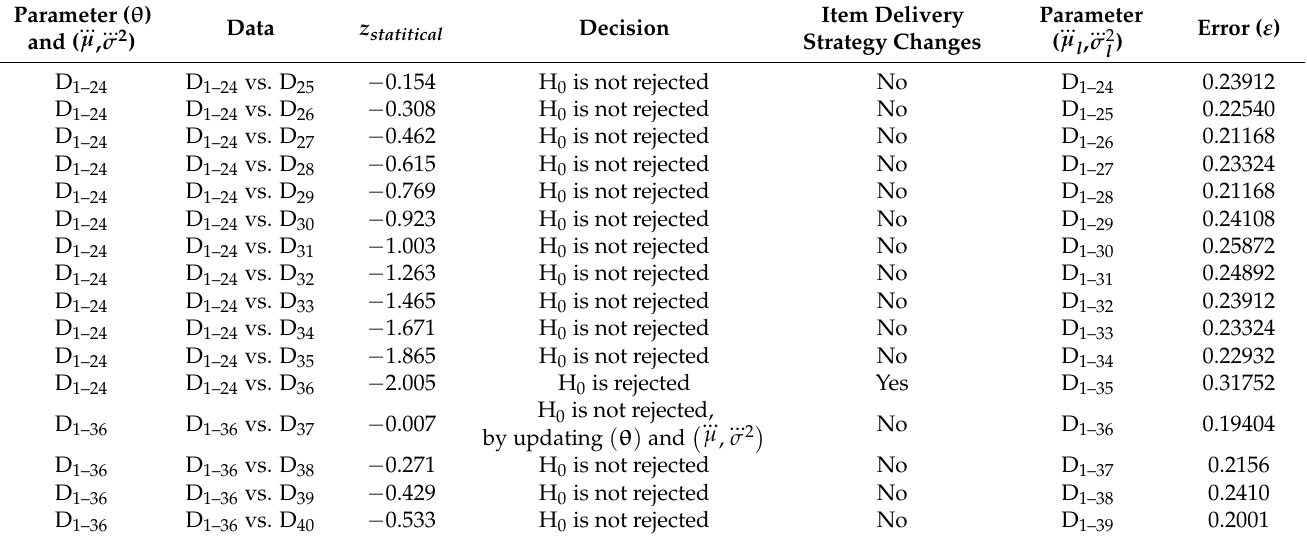
Table 2. Summary of hypothesis testing with α = 0.05 , and 𝑧 (cid:3030)(cid:3045)(cid:3036)(cid:3047)(cid:3036)(cid:3030)(cid:3028)(cid:3039) = 1.96 or 𝑧 (cid:3030)(cid:3045)(cid:3036)(cid:3047)(cid:3036)(cid:3030)(cid:3028)(cid:3039) = −1.96 .